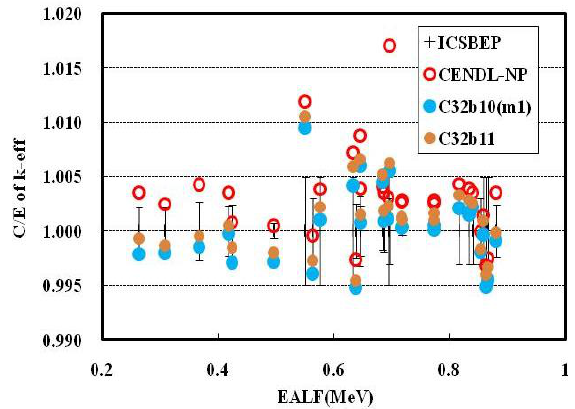
Fig. 14 . The comparison of C/E of keff between ICSBEP, CENDL-NP, CENDL-3.2b10 and CENDL-3.2.